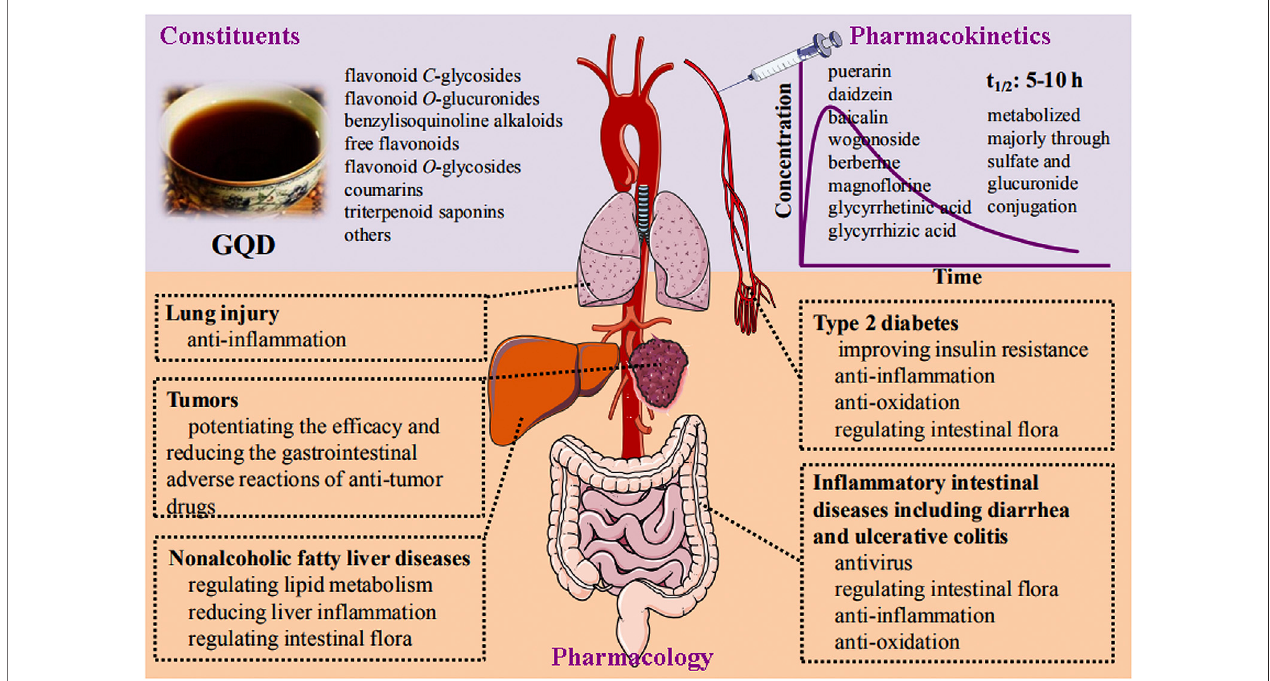
FIGURE 2 | Schematic diagram of constituents, pharmacokinetics, and pharmacology of Gegen- Qinlian decoction.